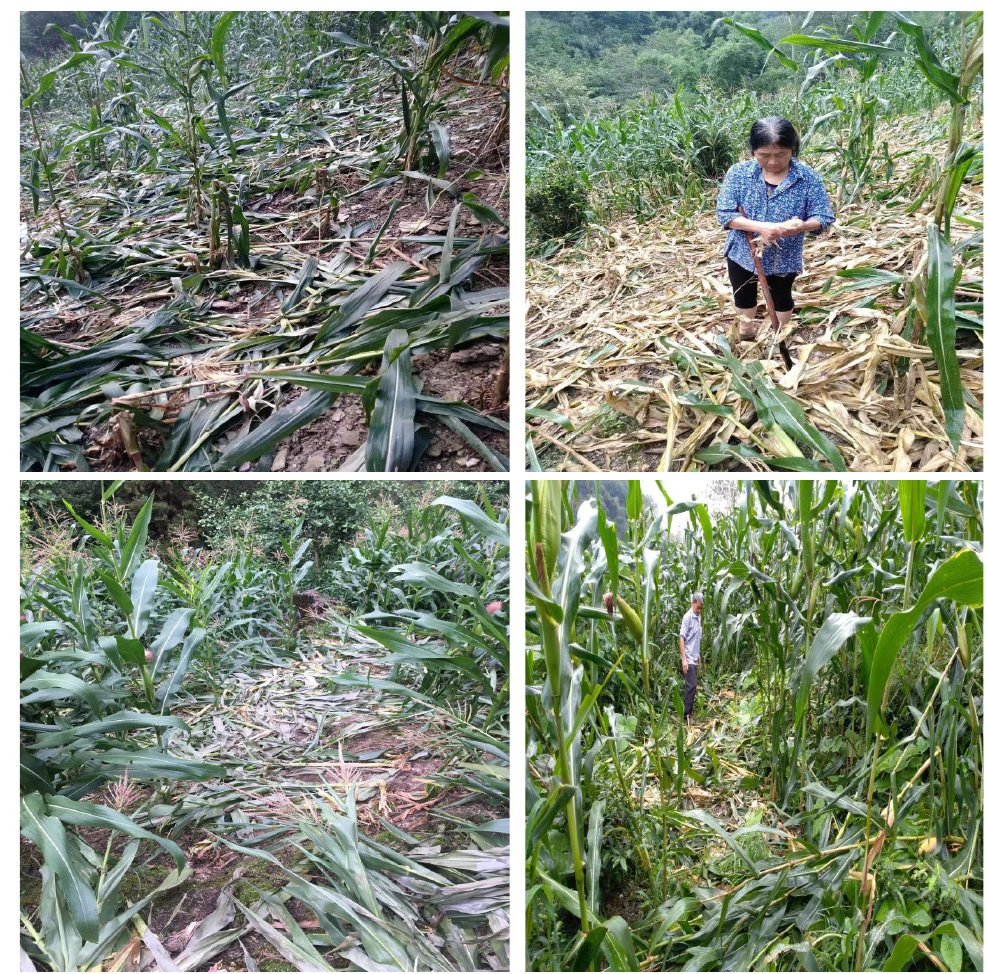
Figure 3. The Sus scrof damage corn scene (these photos were taken by investigators from field investigations.).